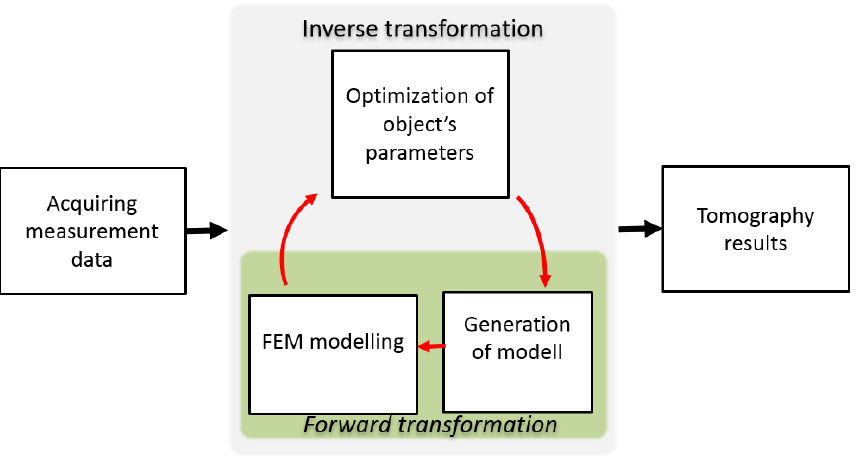
Figure 4. General scheme of inverse tomography transformation for eddy current tomography [20].